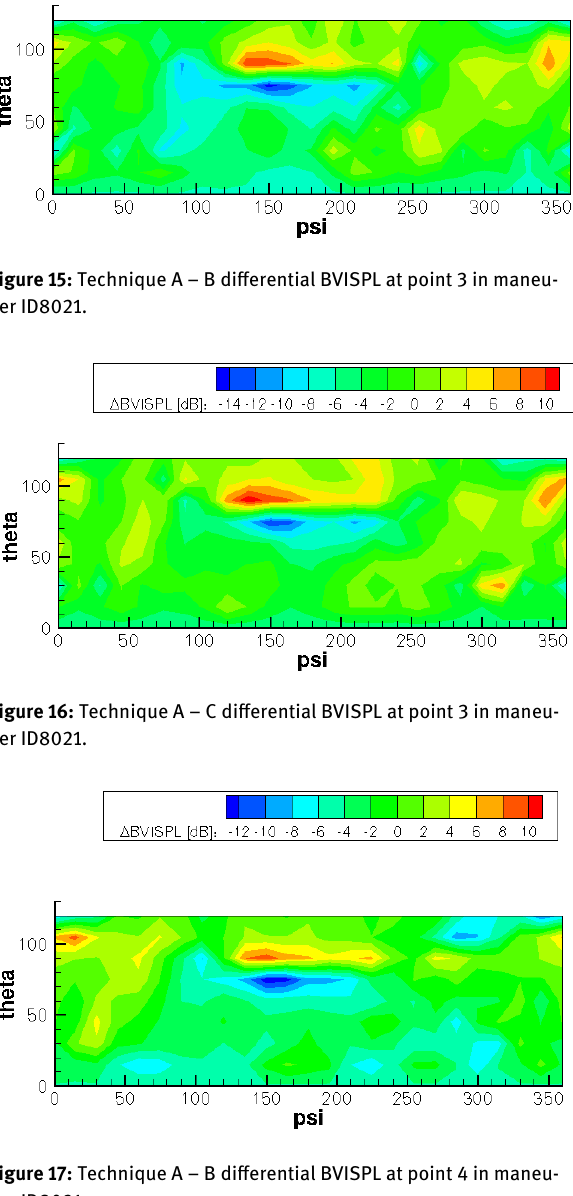
Figure 20: Technique A – C differential BVISPL at point 1 in maneu- ver